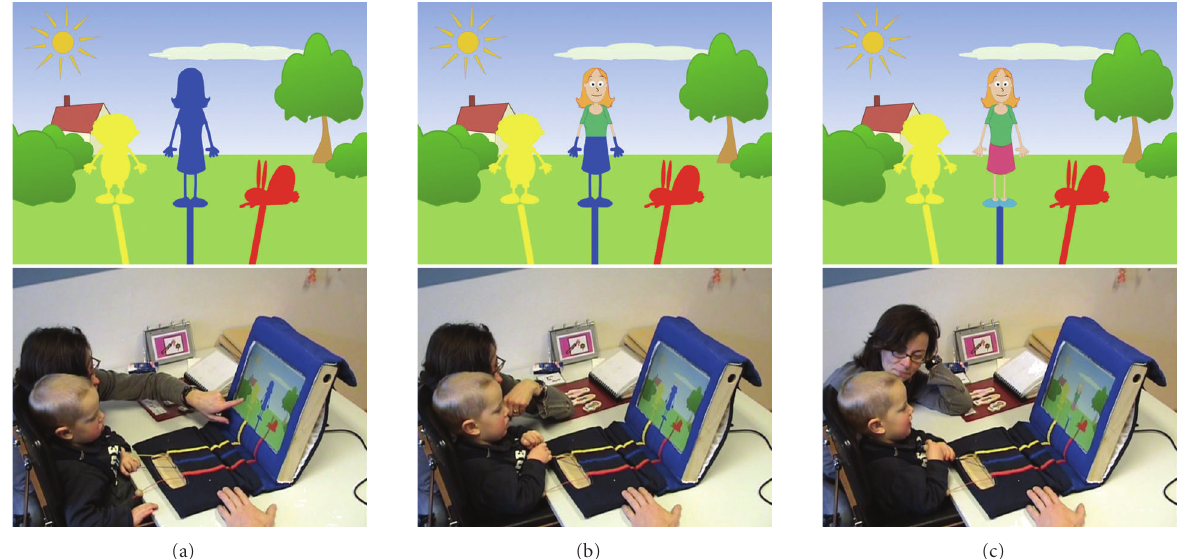
Figure 5: The hiding exercise. From left to right: (a) the speech therapist asks the child who “the blue figure” could be, (b) the child pulls the blue string, and (c) thus reveals the blue